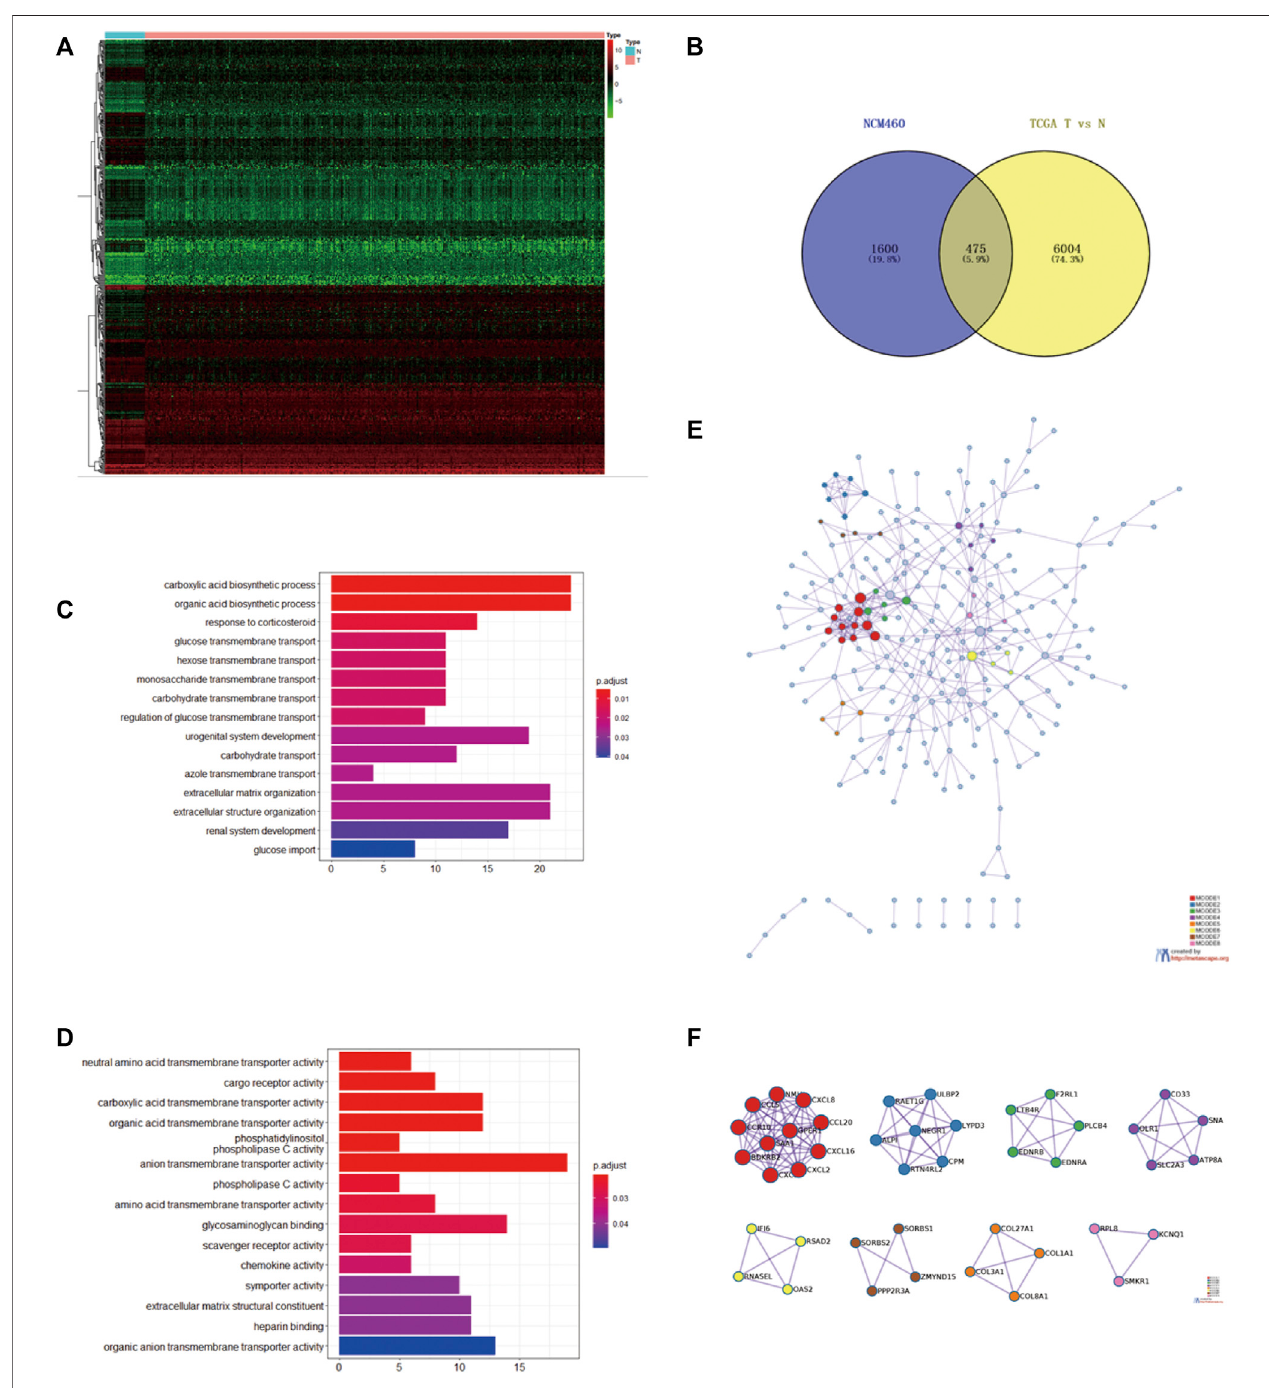
FIGURE 2 | Intersection of the mtDNA-related gene and prognostic gene in TCGA (A) . Heatmap of the top 200 DEGs identi fi ed between tumor and compared normal tissues from COAD in TCGA based on the value of |logFC| (B) . Intersection of 475 common DEGs with the prognostic value in TCGA and EB-treated NCM460 using the Venn diagram. Top three hub modules were classi fi ed in MODE. Red circles represented upregulated genes, while blue circles represented downregulated genes. (C,D) Heatmap of GO enriched terms and biological process (BP) GO enriched terms. (E) PPI network of the common 475 genes calculated by STRING software from the Metascape website (F) Top eight modules of the PPI network; GO, gene ontology; PPI, protein – protein interaction [Color fi gure can be viewed at wileyonlinelibrary.com].